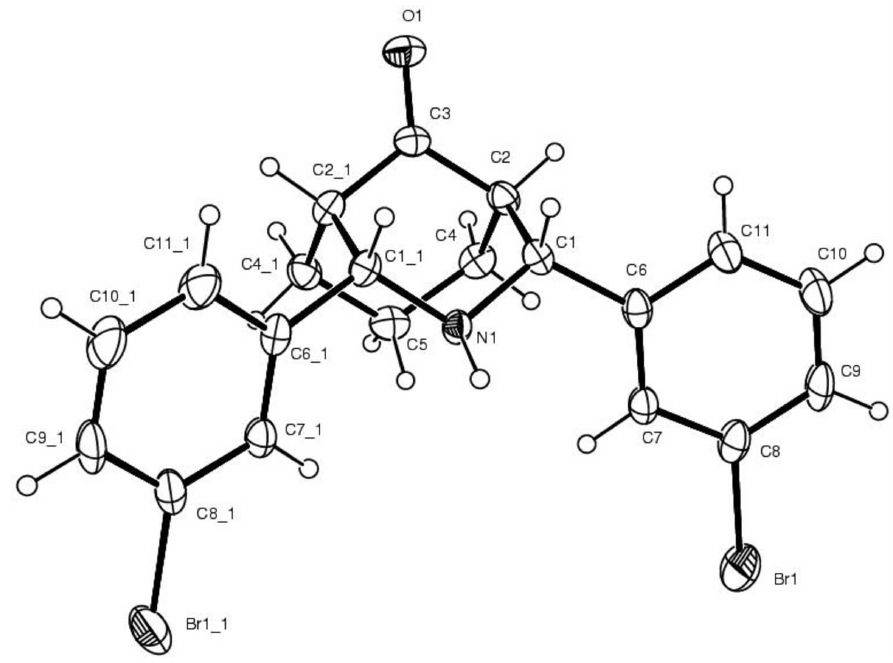
Figure 1 The molecular structure of (I) with non-hydrogen atoms represented as 30% probability